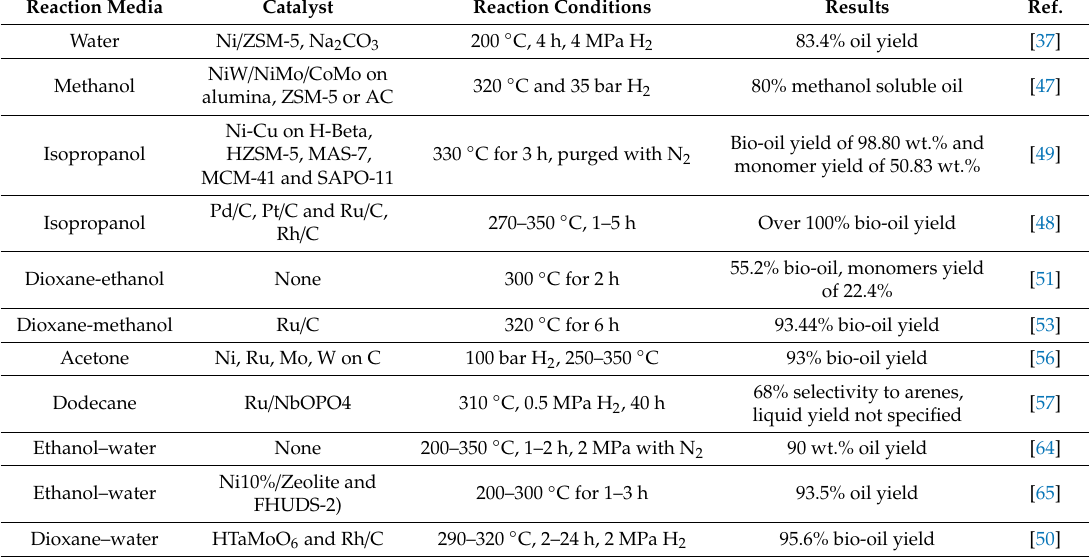
Table 2. Bio-oil yields and products obtained from di ff erent solvolysis studies, ordered on the basis of reaction media